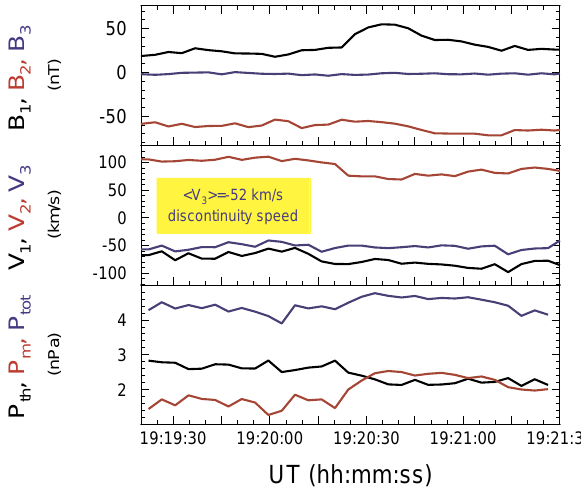
Fig. 4. The magnetic field and the bulk flow velocity for the third discontinuity observed by SC3 (see text). Both vector fields are given in the minimum variance reference frame of the magnetic field. The indices 1, 2 and 3 refer to the maximum, intermediate and minimum variance directions respectively. In the lower panel are plotted the protons thermal pressure P th (black line), the mag- netic pressure P m (red line) and the total pressure P tot = P th + P m (blue